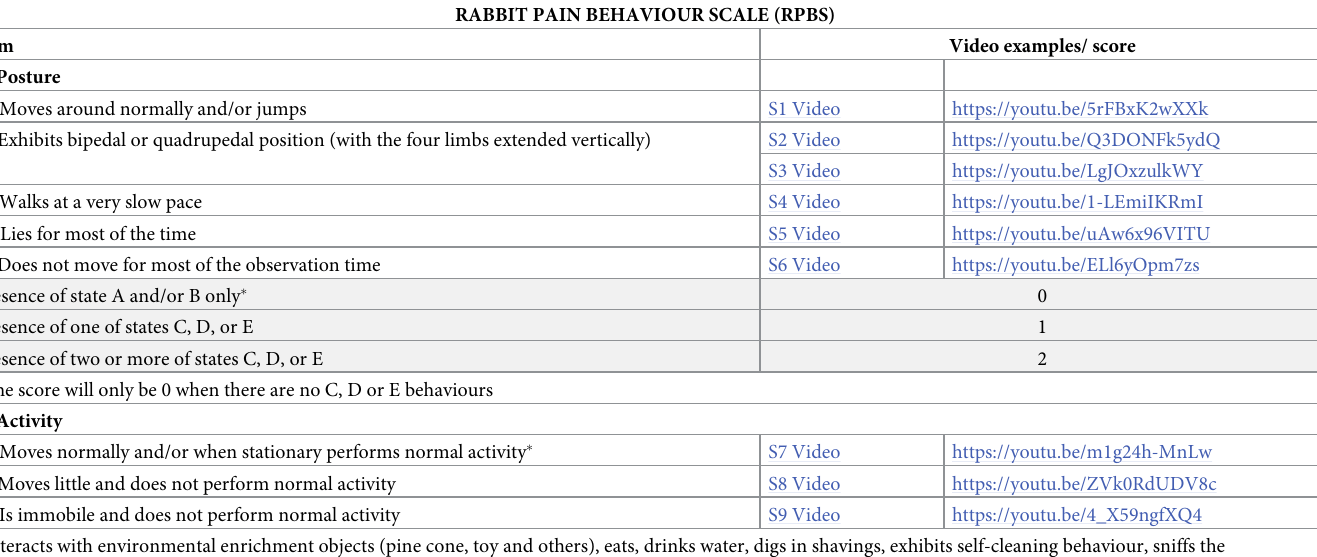
Table 4. Final version of the behavioural scale to assess acute postoperative pain in rabbits (RPBS) after